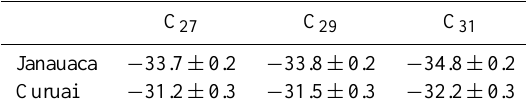
Table 4. Values of long-chain n -alkanes δ 13 C in surface sediment samples from the upstream Lake Janauaca and the downstream Lake Curuai. The samples were collected in the LW